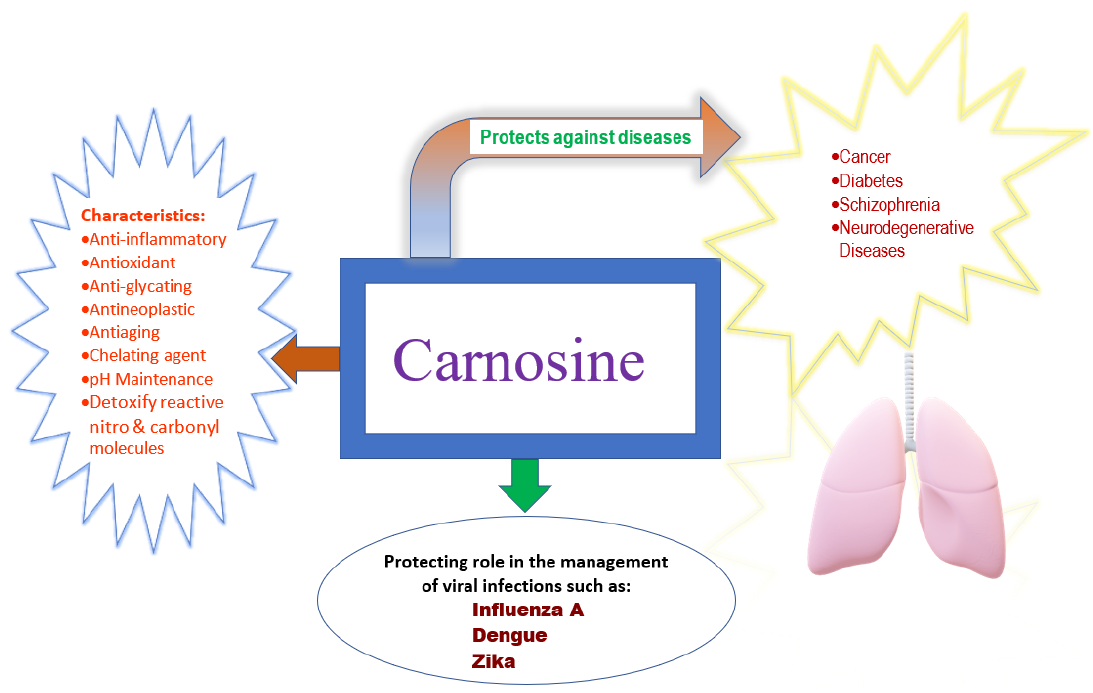
Figure 1. Characteristics and possible therapeutic potential of carnosine.